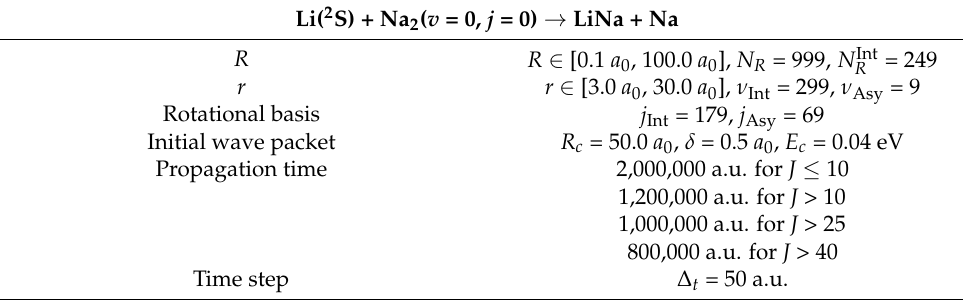
Table 1. Main numerical parameters in the TDWP calculations.